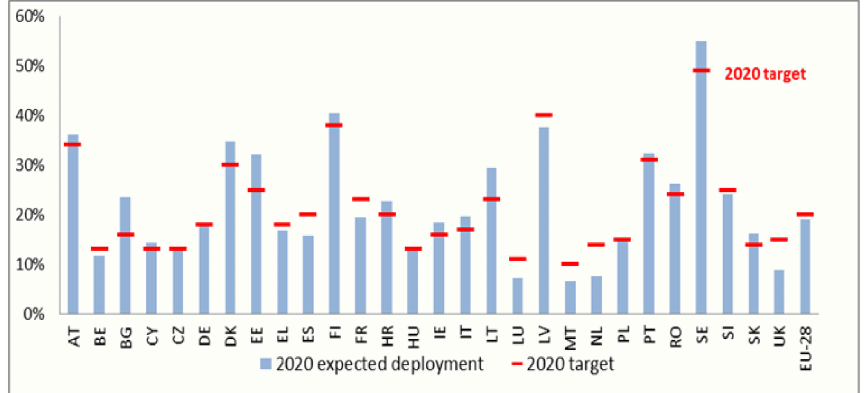
Figure 1. Implementation chart of renewable energy sources (RES) in the EU member states and 2020 targets